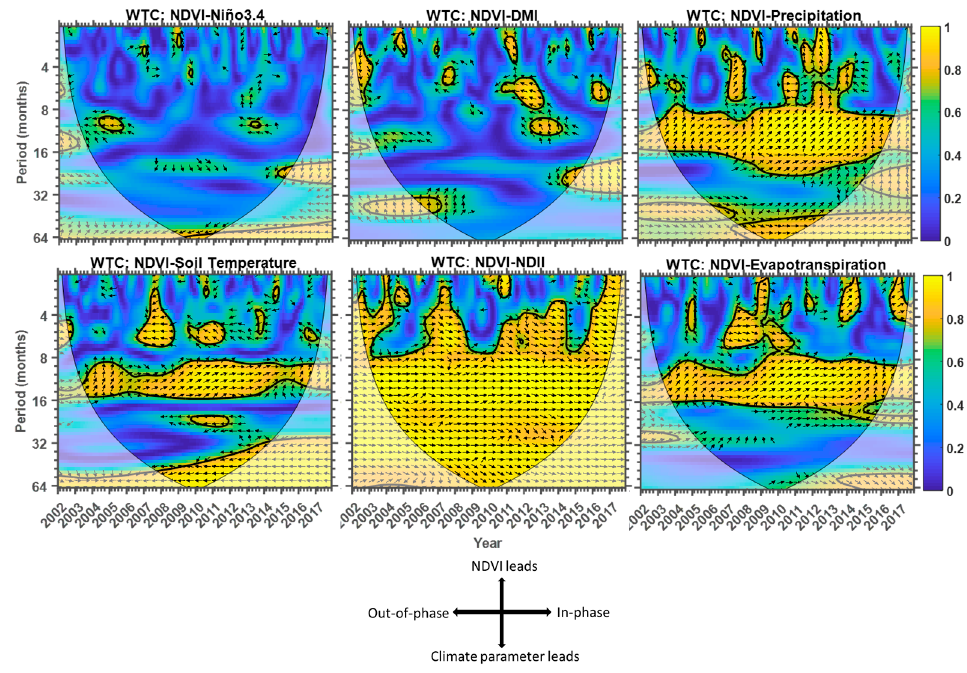
Figure 11. The squared cross-wavelet power spectra for NDVI–Niño3.4, NDVI–DMI, NDVI- precipitation, NDVI–soil temperature, NDVI–NDII, and NDVI–ET. The continuous black lines demarcate the areas of significance at the 95% confidence level using the red noise model. The arrows are vectors indicating the phase difference between the cross-wavelet parameters (see the legend in the bottom left